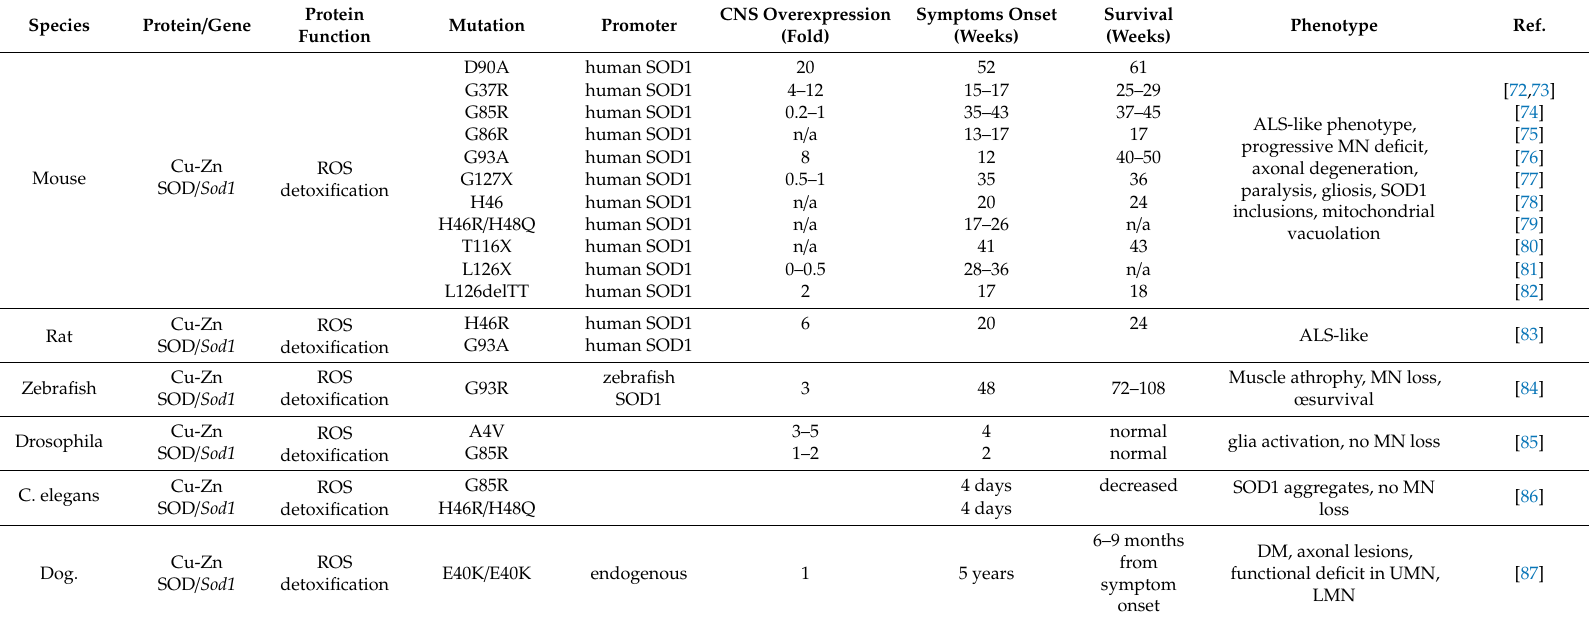
Table 1. Summary of representative SOD1 animal models of